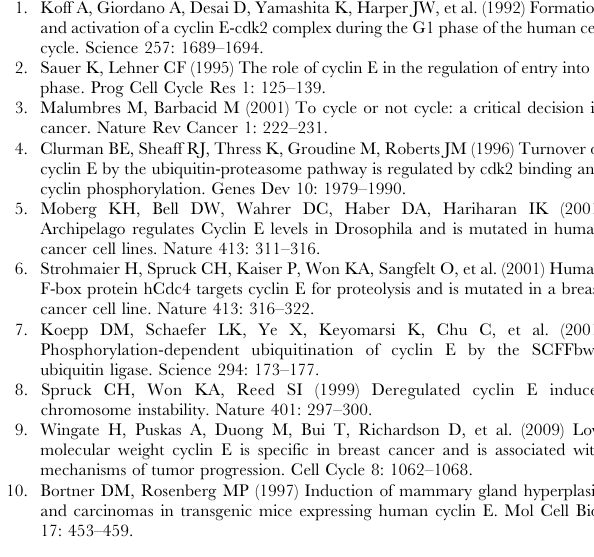
Figure S1 Cyclin E siRNA inhibits colony formation in soft agar in cyclin E-overexpressing cells, but not in cyclin E-low expressing cells. Here shown are the representative data of colony formation in soft agar from SK-BR3 (top panel) and T47D (bottom panel). The viability of each group (%) was monitored as described in Methods section, and indicated at the bottom of each